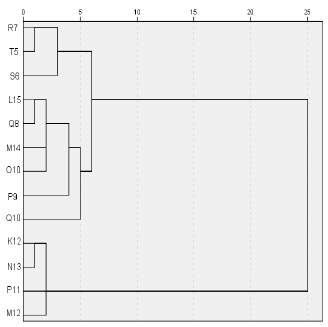
Figure 11. Cluster analysis of sampling sites in the wet season.